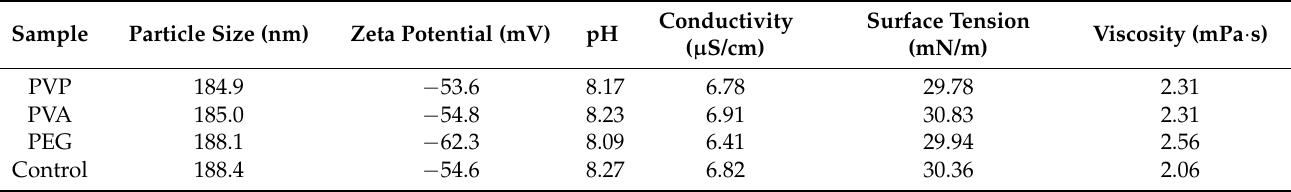
Table 3. Physicochemical properties of disperse